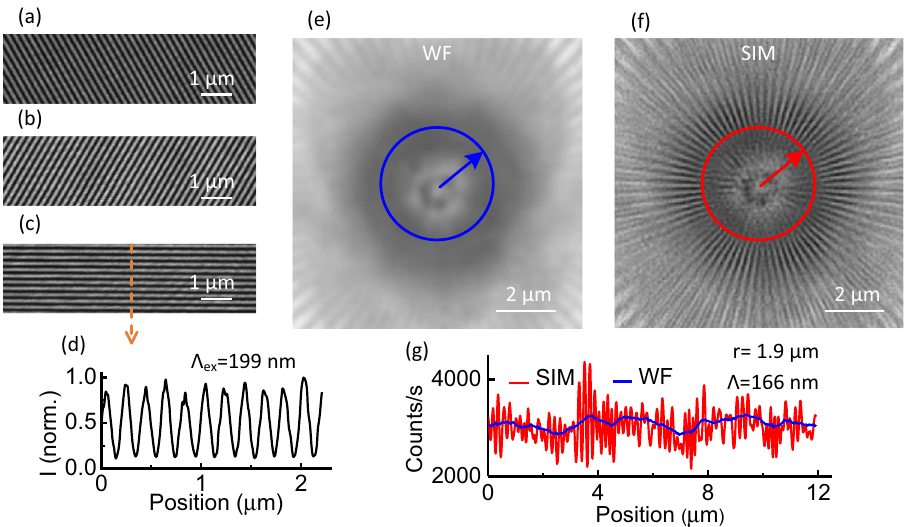
Fig. 4 | UV-PIC SIM with NA ex = 0.9. a – c Optical images of the UV interference fringe patterns in the case of NA ex = 0.9 for the D 1 , D 3 , and D 2 illumination orien- tations, respectively. d Normalized intensity pro fi le along the dashed line in c . Λ ex : modulationperiodofthefringepattern. e and f Standardwide- fi eld(WF)imageand